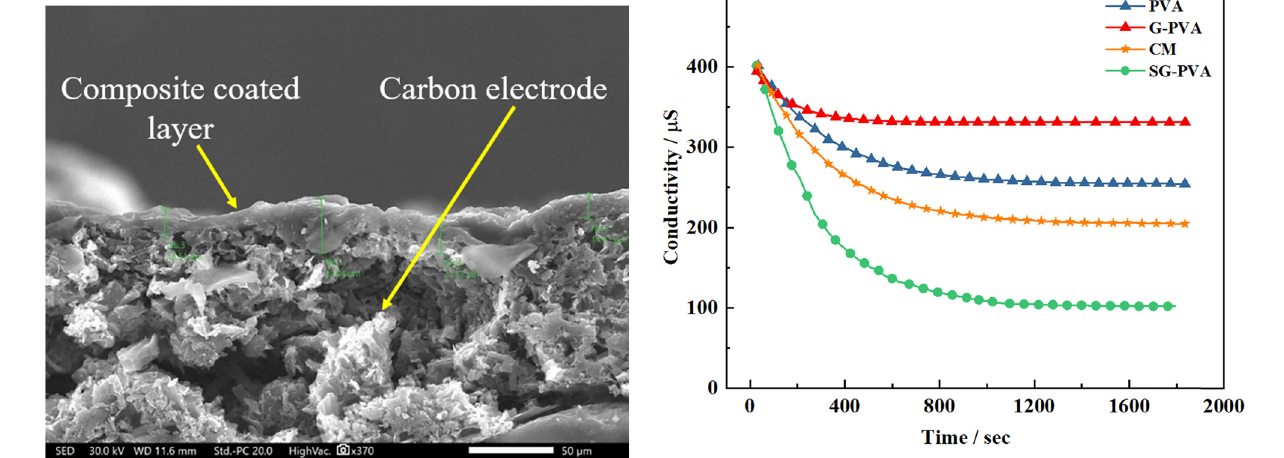
Figure 5: SEM image of SG - PVA membrane electrode.